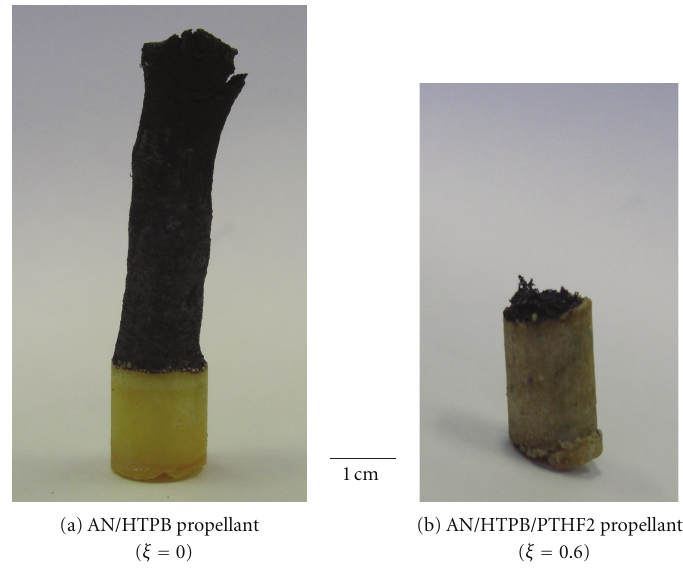
Figure 2: Photograph of propellant quenched at 7 MPa.